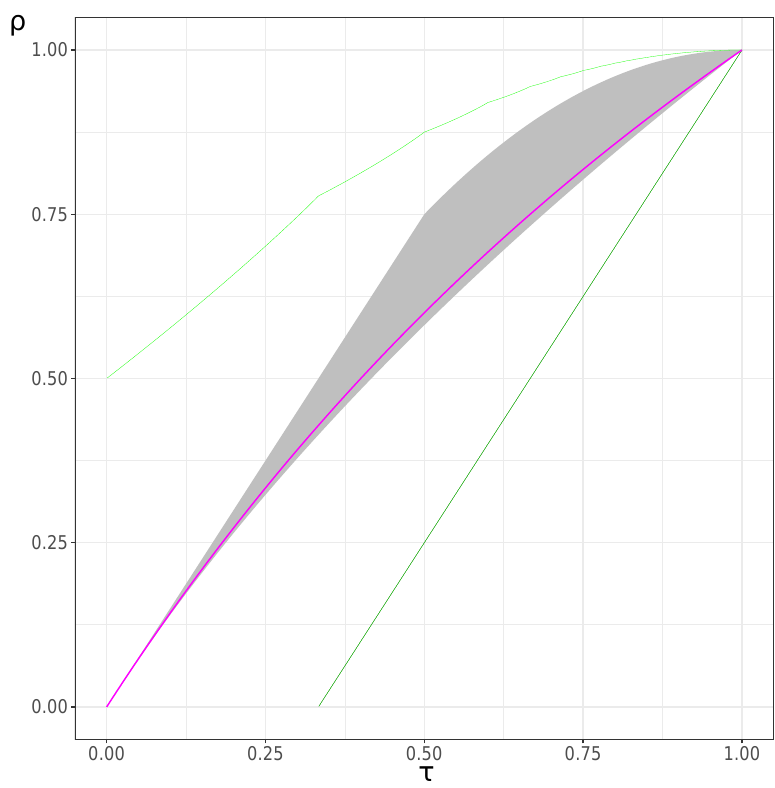
Figure 2: The region determined by the Hutchinson-Lai inequalities (gray), the boundary of the full τ - ρ -region as recently estab- lished in [15] (green), and the sharp inequality derived in this paper